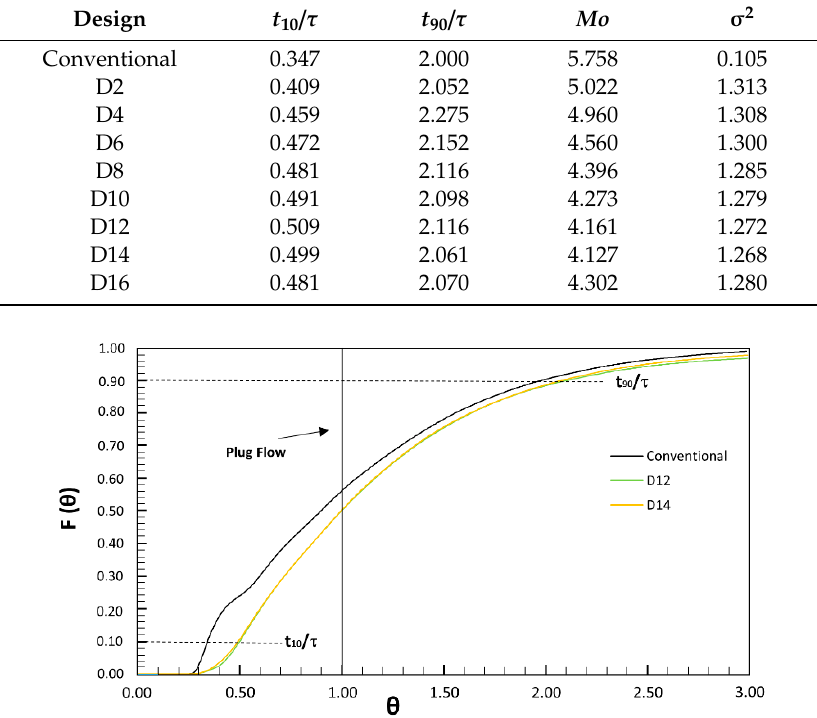
Table 3. Hydraulic efficiency indicators for conventional and perforated baffle designs. Design